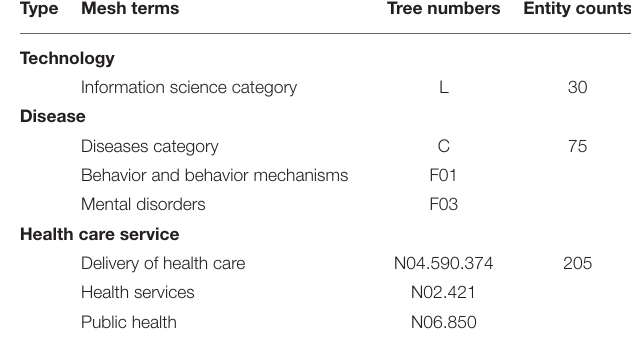
TABLE 4 | Entity extraction